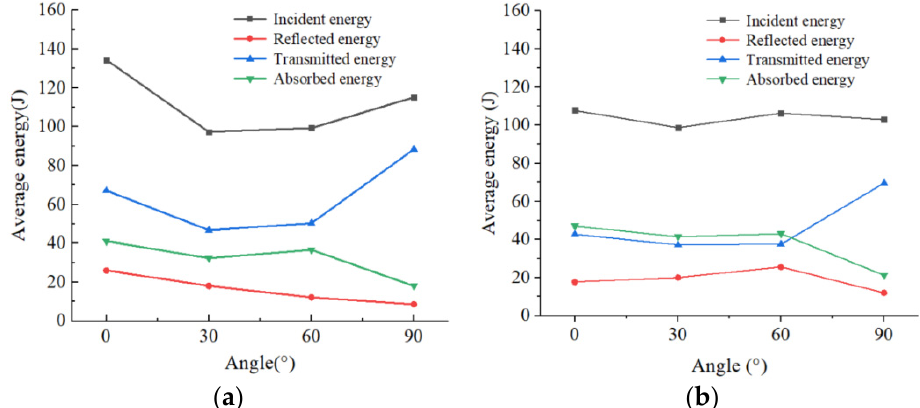
Figure 10. Energy relationship curves for different stratification angles: ( a ) dry state; and ( b ) satu- rated state .